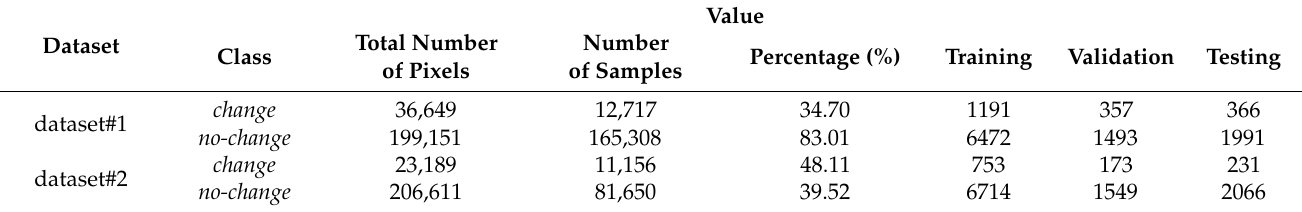
Table 5. The number of change and no-change pixels extracted from the parallel pseudo-label genera- tion framework and the number of training, testing and validation pixels used in the training process of